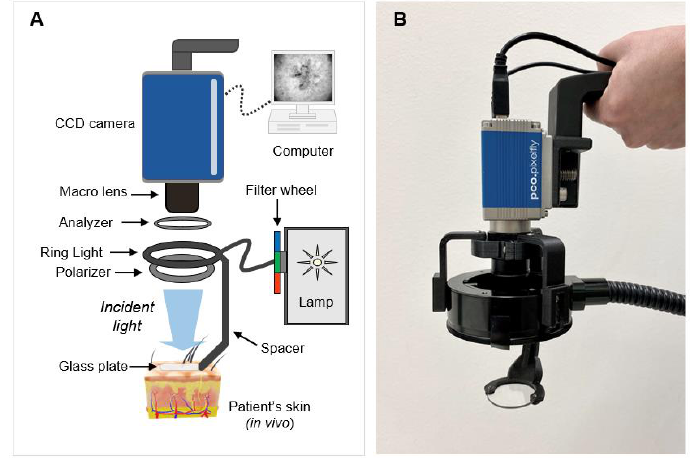
Figure 1. Handheld optical polarization imaging (OPI) system. ( A ) Schematic diagram; ( B ) Photo- graph of the device.